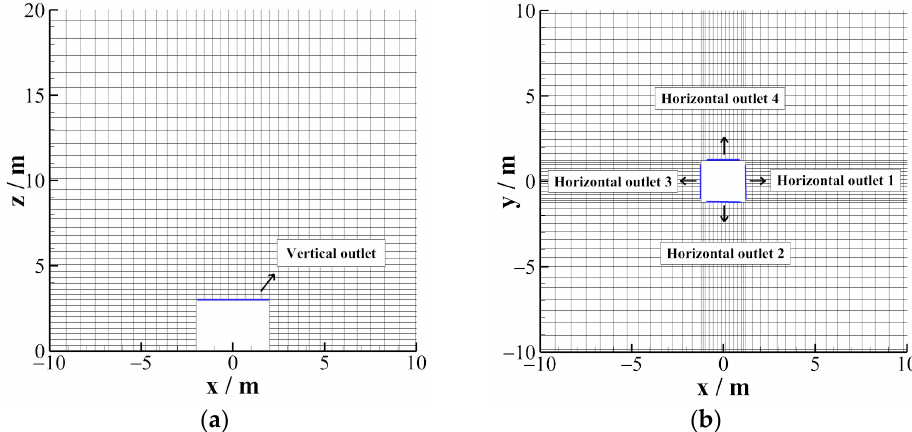
Figure 2. Grid diagram of the upper vent: ( a ) vertical discharge pattern; ( b ) horizontal discharge